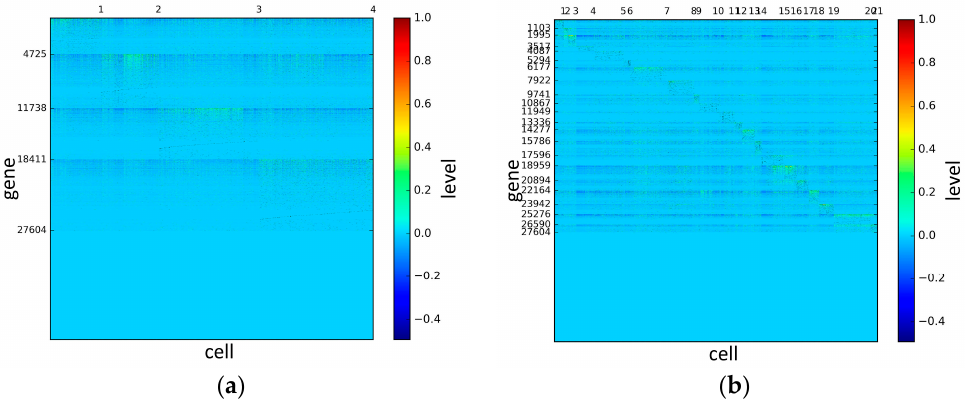
Figure 8. The heat maps of Chung datasets.